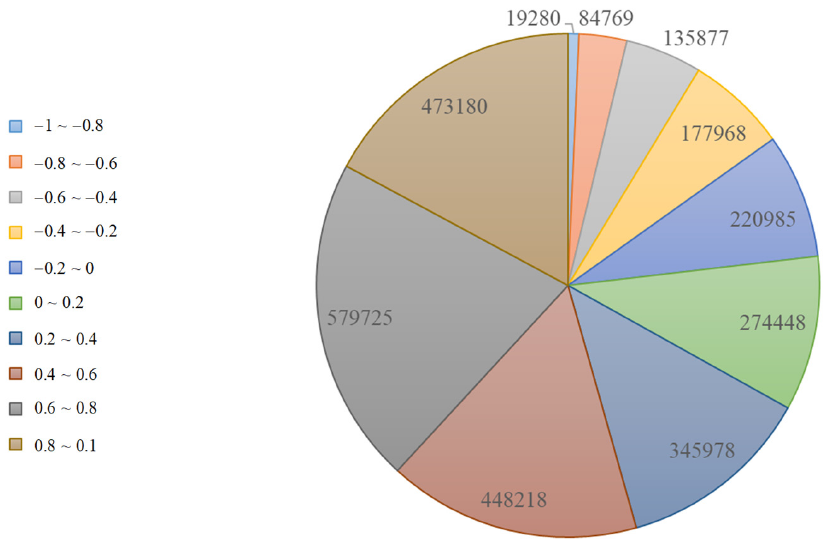
Figure 6. Distribution of correlation coefficients between companies.